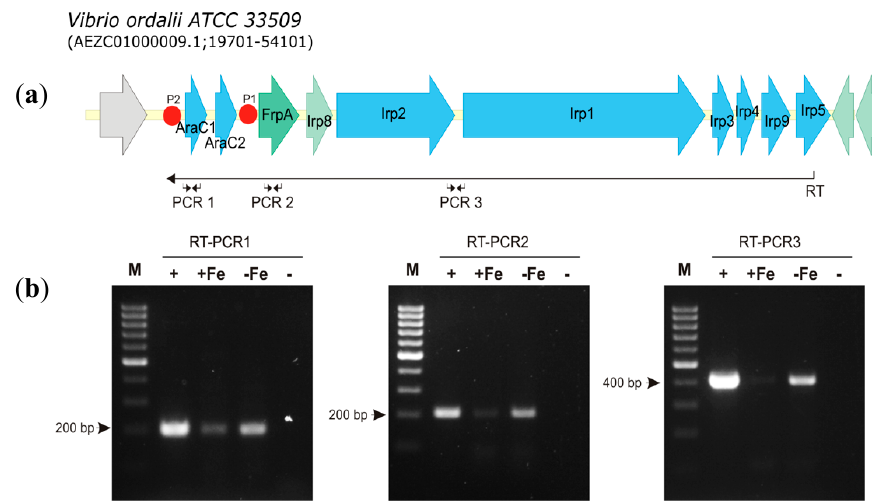
Figure 3. Transcriptional organization of the gene cluster putatively encoding biosynthesis and transport of siderophore piscibactin in V. ordalii . ( a ) The predicted gene functions are: biosynthesis, genes irp1 , irp2 , irp3 , irp4 , irp5 and irp9 ; outer membrane receptor, frpA ; transcriptional regulators, araC1 and araC2 ; and inner membrane exporter of putative siderophore, irp8 . Predicted promoters P1 and P2 containing Fur boxes are indicated by red dots. RT denotes the location of primer used in retrotranscriptase reaction while PCR 1, PCR 2 and PCR 3 indicate location of primers for detection of cDNA from piscibactin gene cluster. ( b ) results of three RT-PCR reactions designed to analyze the transcription of the irp gene cluster. Primer marked as RT, targeted to the 3 ′ -end of irp5 gene, was used to obtain a cDNA that spanned from irp5 to araC1 . This cDNA was then used as template for three PCR reactions targeted within araC1 (RT-PCR1), frpA (RT-PCR2) and between irp2 3’-end and irp1 5’-end (RT-PCR3). M, size marker from 100 to 1000 bp. Negative controls (-) are RT-PCR